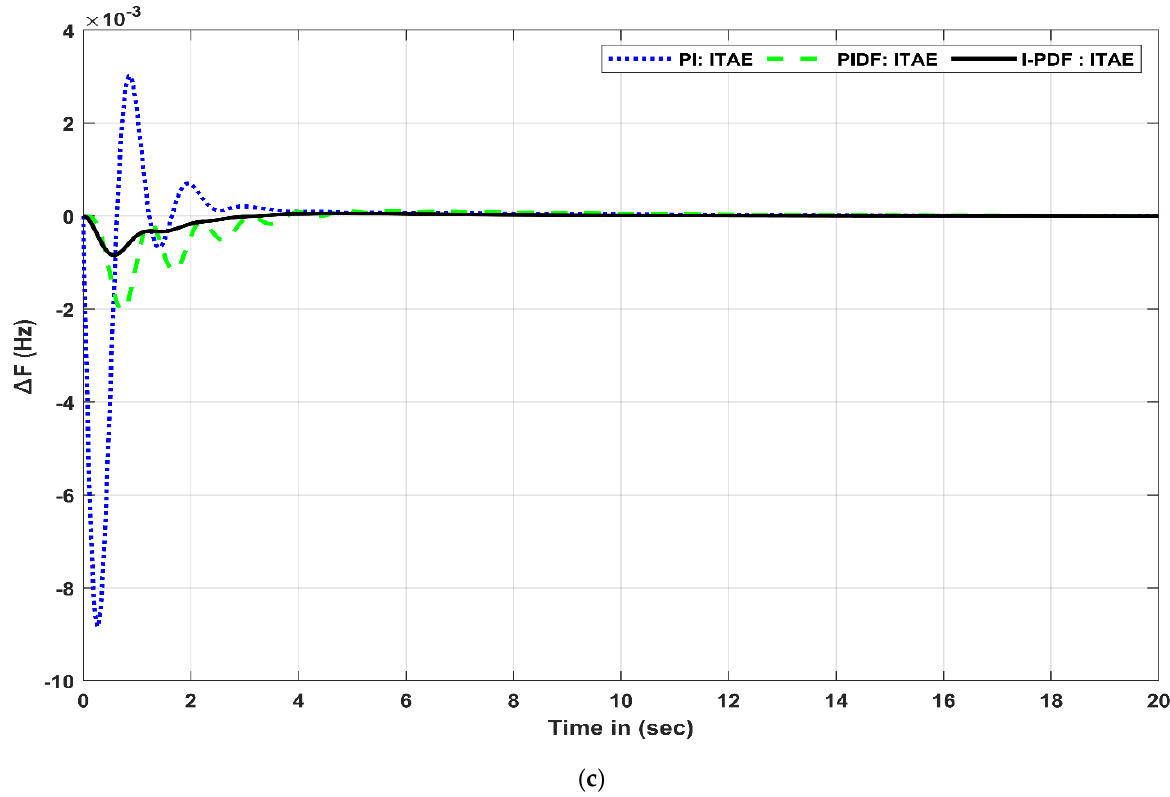
Figure 6. Dynamic response of the marine microgrid system for scenario1 ( a ) ITSE ( b ) ISE ( c ) ITAE. Table 2. Comparison performance of various controllers using different performance indices.